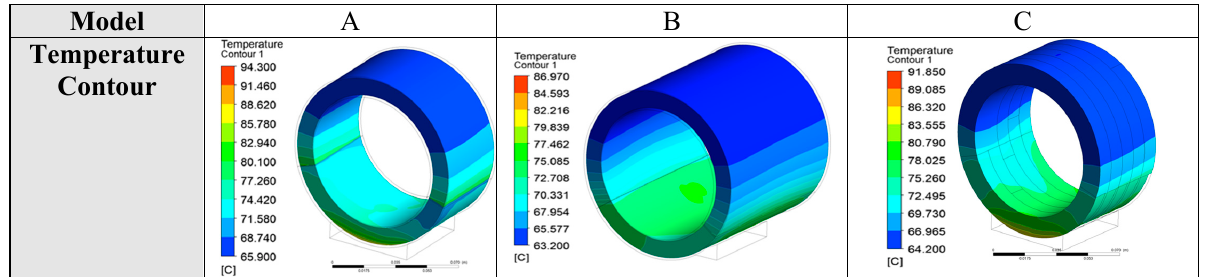
Fig. 14. Temperature contour of 3D concentric annular heat pipe. Figure 14. Temperature contour of 3D concentric annular heat